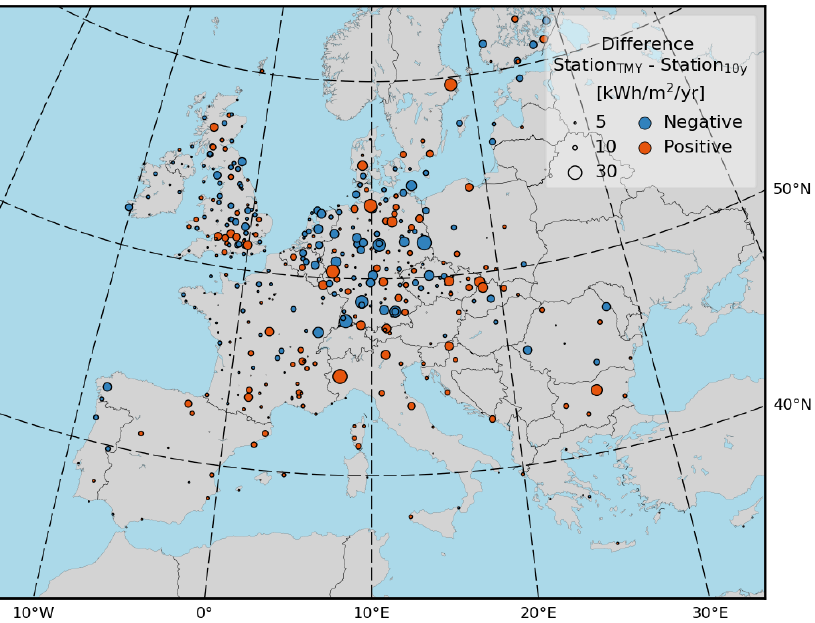
Figure 5. Map showing difference in EnergyPlus calculation for heating energy consumption when using the station-based Typical Meteorological Year (TMY) data instead of the full 10-year station data. Values are shown as kWh/m 2 difference, with the size of the marker indicating the magnitude of the difference. Calculation is for the single-family house